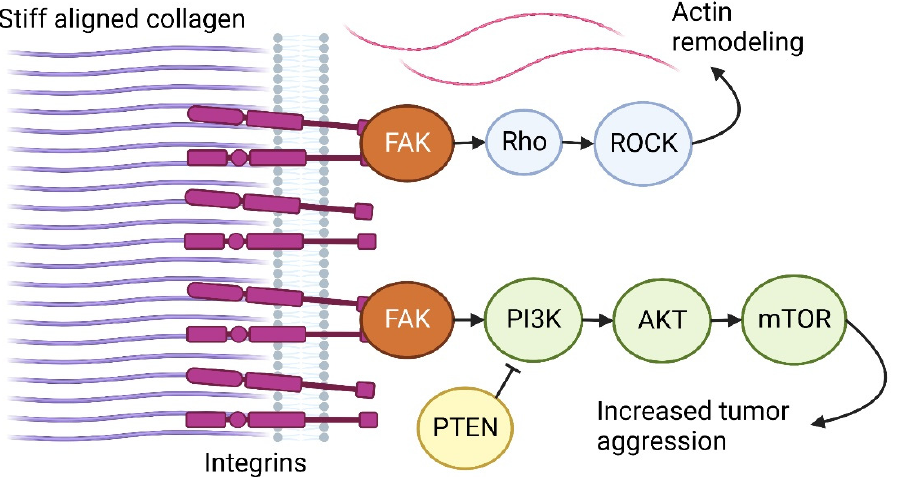
Figure 2. Mechanotransduction. Increased ECM stiffness activates integrin-dependent focal adhesion formation. Consequently, several pathways are activated, such as Rho/ROCK and PI3K/AKT/mTOR, which cause actin remodeling and increased tumor aggression. Created with BioRender.com, accessed on QE24CTMVV9, 2 nd Sep, 2022.